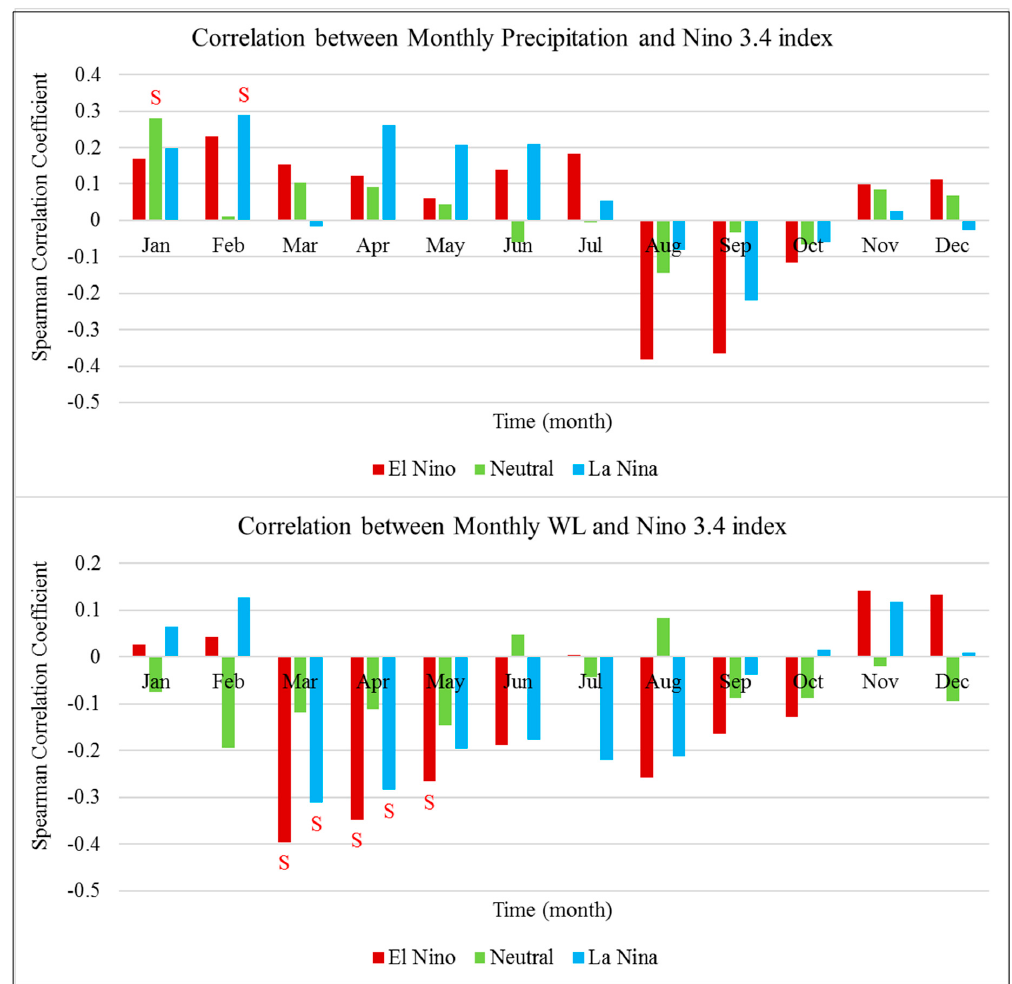
Figure 5. Spearman’s correlation coefficient between the Niño 3.4 index and precipitation ( top figure) and WL ( bottom figure) in monthly scale. S indicates the significant correlations at 95% confidence